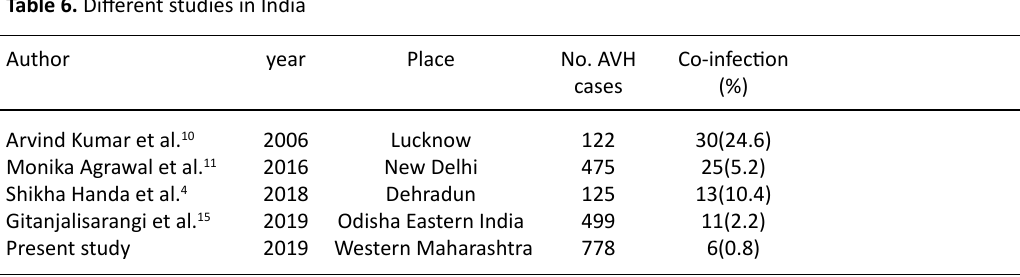
Present study Table shows frequency and changing trend of co-infection in different geographical areas in